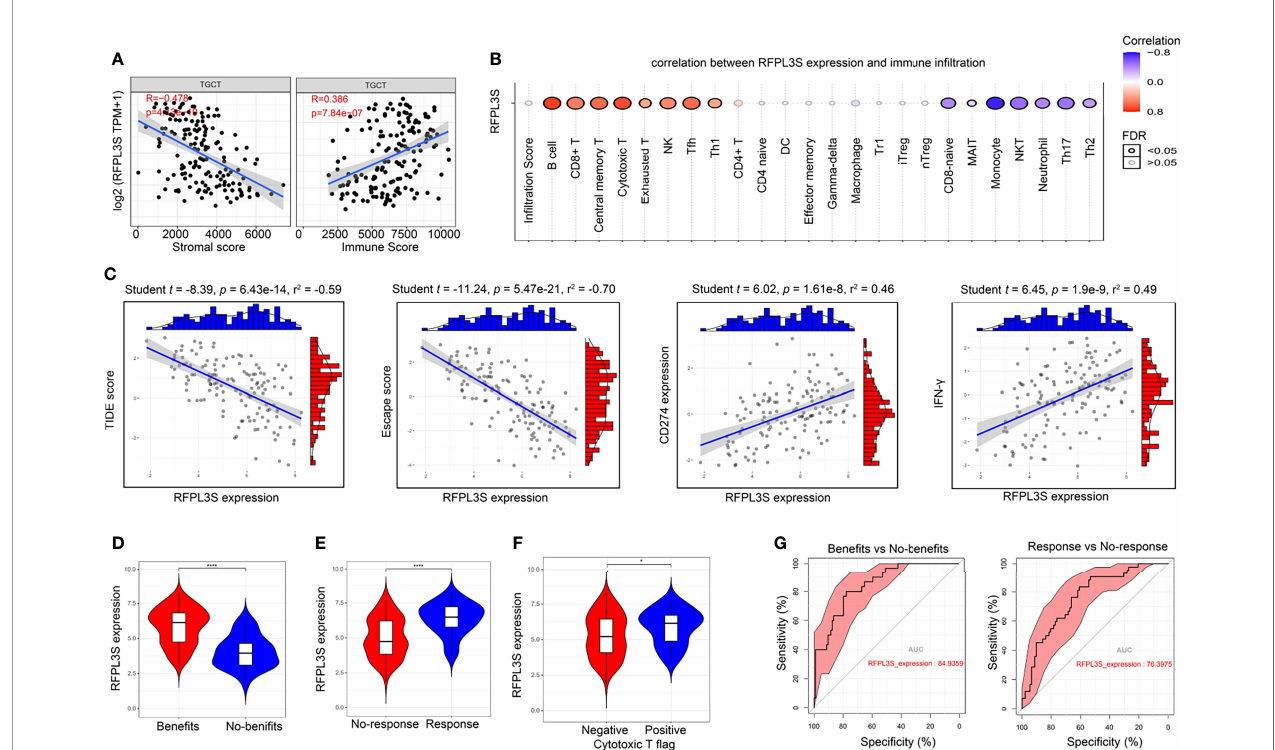
FIGURE 6 | The association of RFPL3S and TGCT tumor immunity. Tumor Immune Dysfunction and Exclusion algorithm was used to predict the response of a single sample to predictive immune checkpoint inhibitors based on the TCGA TGCT expression pro fi le data. (A) RFPL3S expression was negatively correlated with stromal score, and positively correlated with Immune score. (B) Correlation between RFPL3S expression and immune in fi ltrates in TGCT. (C) Correlation between RFPL3S expression and TIDE score, exclusion score, CD274 expression, and IFN- g score in TGCT. (D – F) higher RFPL3S expression was present in the immunotherapy bene fi t, response, and cytotoxic T fl ag positive patients. (G) RFPL3S had a high diagnostic sensitivity and speci fi city for distinguishing immunotherapy bene fi ts from no-bene fi ts (AUC = 84.9359), and response from non-response (AUC = 76.3975). *P < 0.05, ****P <